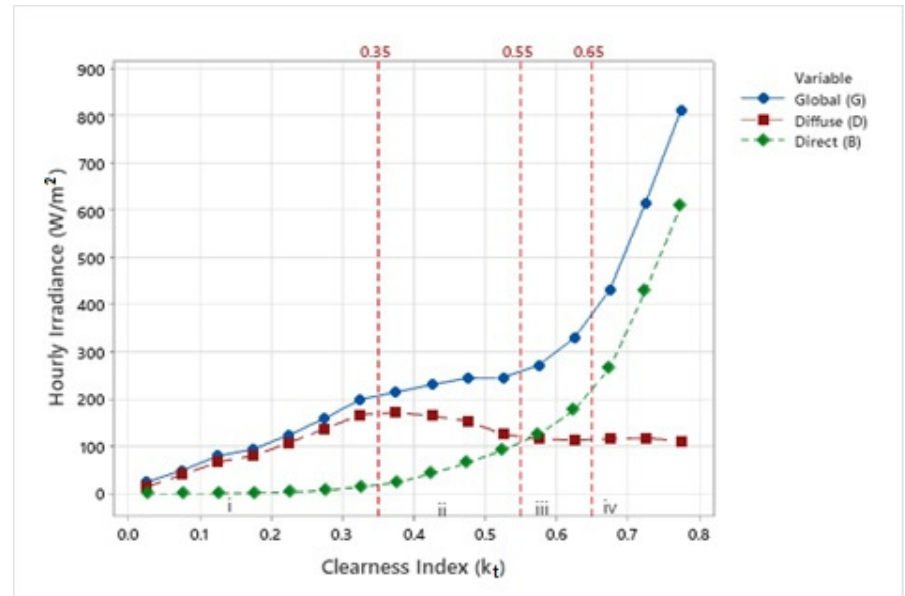
Figure 2. Block-average values of global, diffuse and direct components of solar radiation, at the surface, in terms of clearness index intervals. Vertical dashed lines define regions of k t values associated to sky conditions and identified by i (cloudy sky), ii (partially cloudy with predominance of diffuse component), iii (partially cloudy with predominance of direct component) and iv (clear sky) interval.